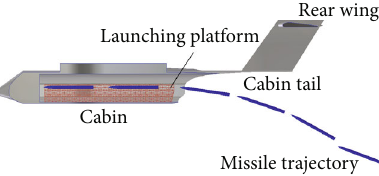
Figure 1: Horizontal backward launch.